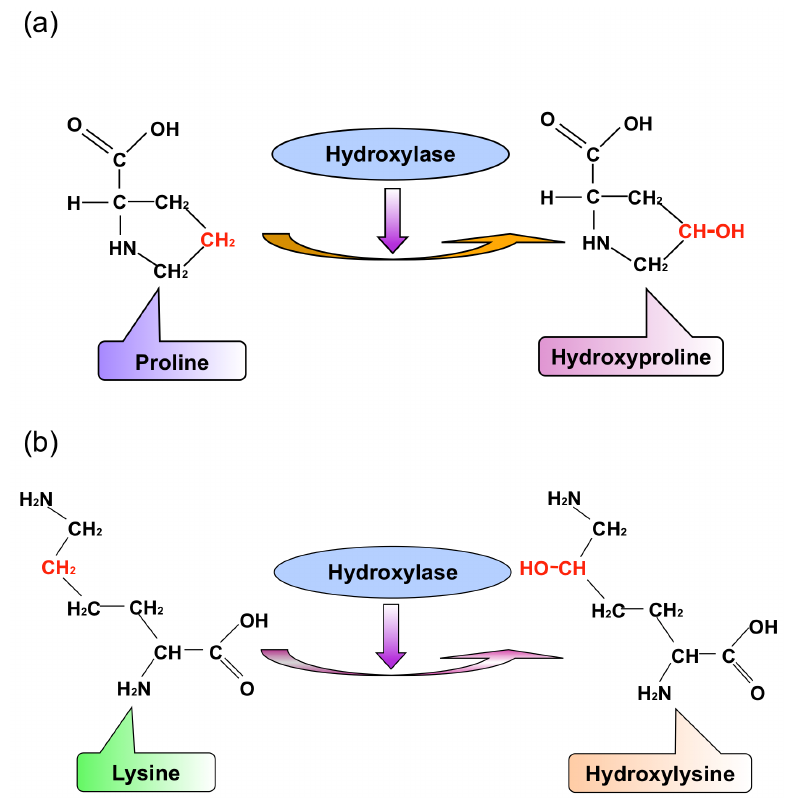
Figure 1. Schematic drawing to show protein hydroxylation occurring at ( a ) proline and ( b ) lysine to form hydroxyproline (HyP) and hydroxylysine (HyL),